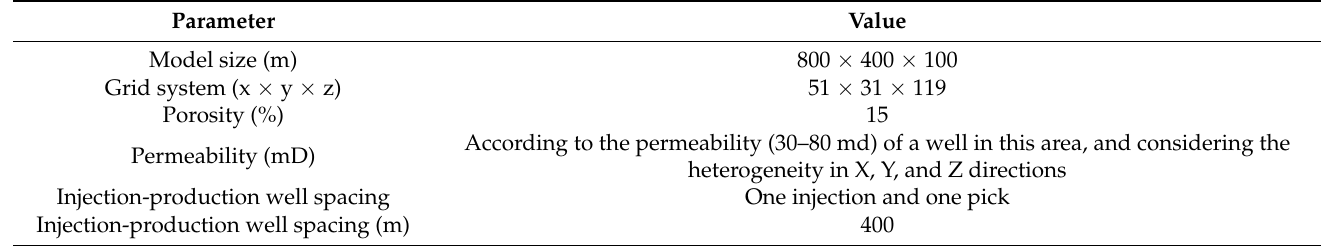
Table 1. Main parameters of the numerical simulation mechanism model.